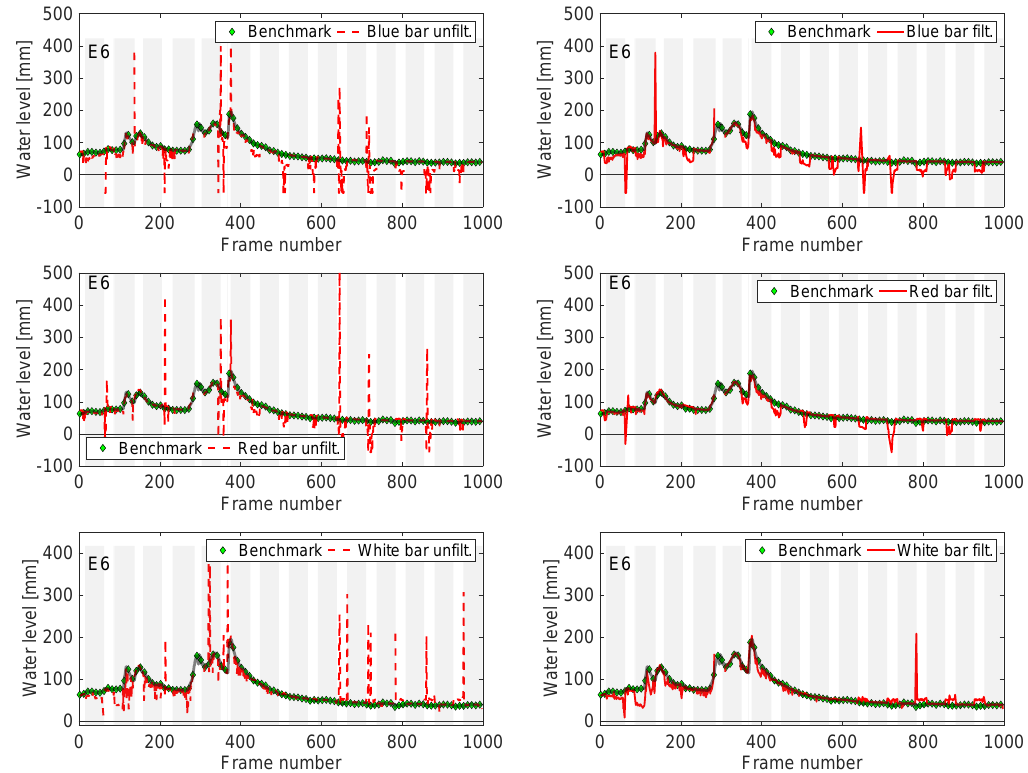
Figure 6. Raw ( left ) and filtered ( right ) water levels computed from the bars ( top : blue, middle : red, bottom : white) for experimental test E6. Benchmark water levels are in green markers and transparent black; bar raw and filtered in dashed and solid red, respectively. Light gray vertical bars indicate NIR frames. Images are treated with the narrow image